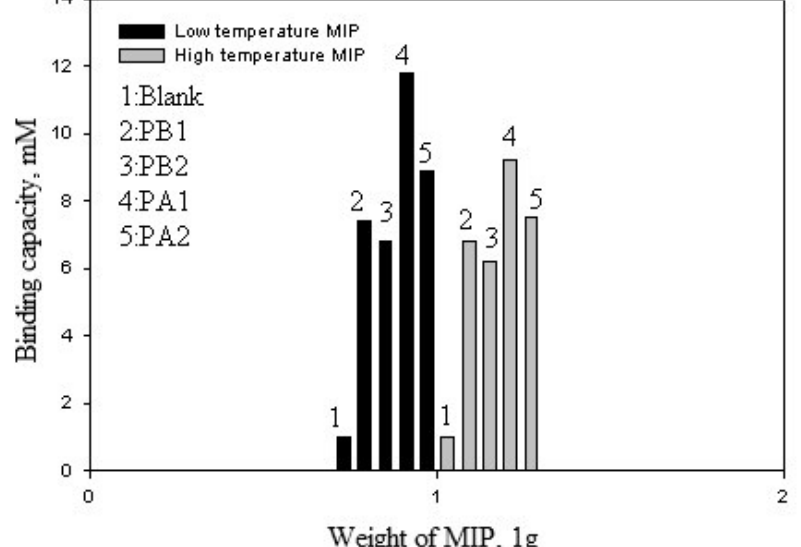
Figure 3. Different binding results of Neu5Ac from the MIPs under high temperature (60 0 C) and low temperature (4 0 C)